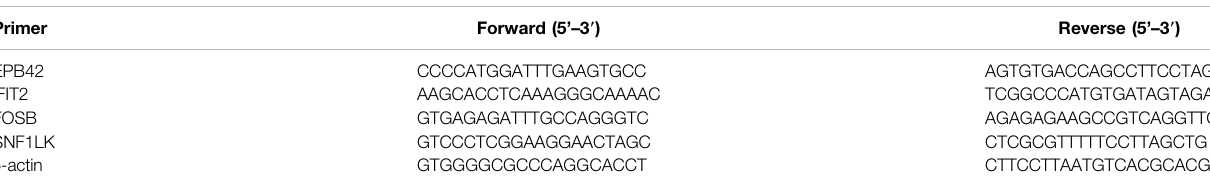
TABLE 1 | Primer sequence of optimal feature